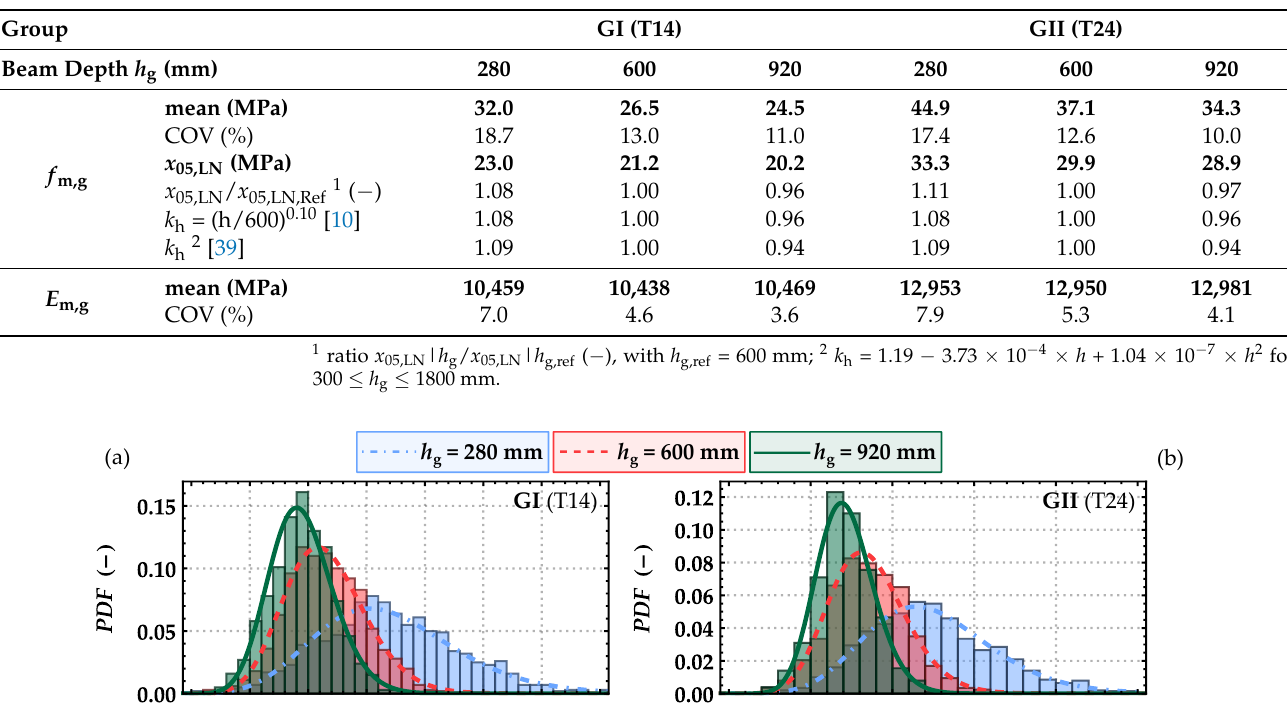
Table 11. Main statistics for the bending strength f m,g and the modulus of elasticity E m,0,g as calculated from the data of 10 3 simulated glulam beams for each setting for a width of w g = 150 mm, various depths and base material GI (T14) and GII (T24).